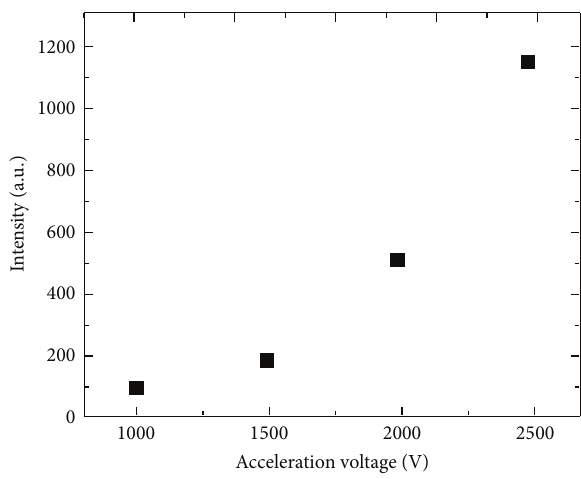
Figure 3: Output CL intensity of the Nd 3+ : LuF 3 thin film at 179 nm for acceleration voltages ranging from 1 to 25 kV.